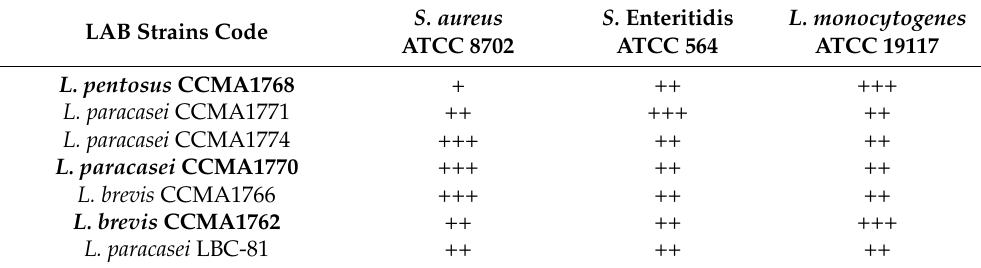
Table 3. Antibacterial activity of LAB isolates. LAB Strains